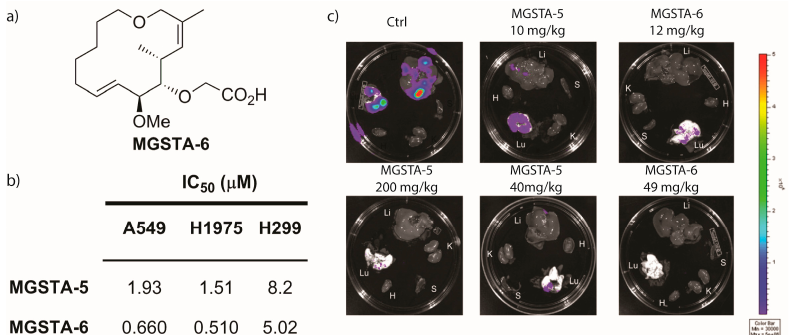
Figure 6. ( a ) Structure of MGSTA-6 a; ( b ) Chamber cell migration assay with non-small lung carcinoma (NSLC) A549, H1975, H1299 cells; ( c ) Bioluminescent imaging of tumor metastasis at endpoint. Lung (Lu),